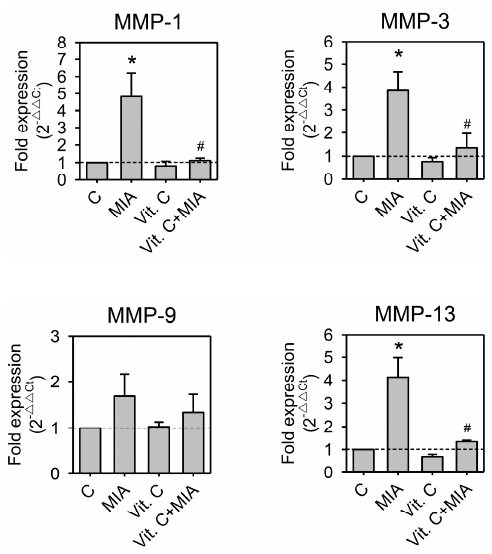
Figure 7. Effects of MIA and/or vitamin C on matrix metalloproteinase (MMP) expressions. SW1353 cells were incubated with 100 μ M vitamin C in the presence or absence of 5 μ M MIA for 24 h; then, the cells were harvested and the mRNA was extracted, followed by reverse transcription and real-time PCR analysis for MMP-1, MMP-3, MMP-9, and MMP-13. The data are expressed as fold changes compared to untreated control. The dashed line shows Y = 1 of control for reference. The results are the mean ± S.D. for three separate experiments, each in triplicate. * p < 0.05 compared to the untreated control. # p < 0.05 compared to the MIA treated group.